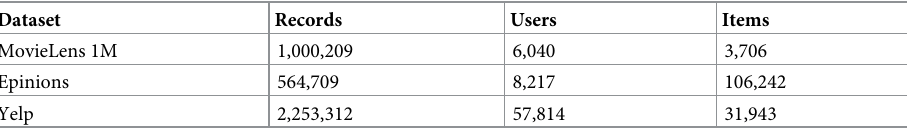
Table 3. The number of records, users, and items in each dataset after preprocessing. Dataset